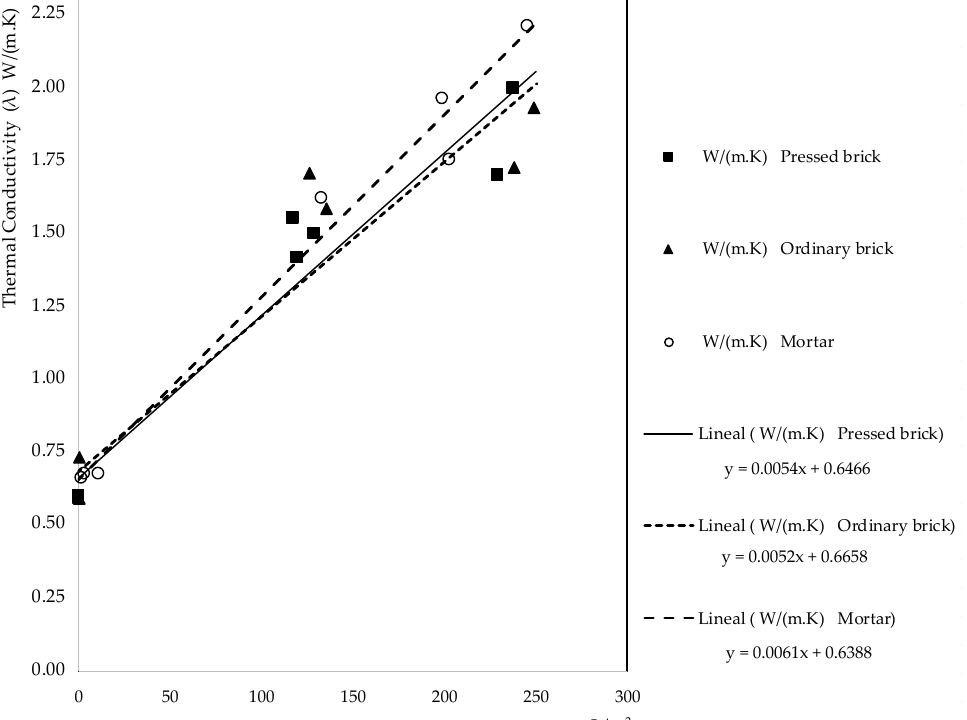
Table 1. Material test values.